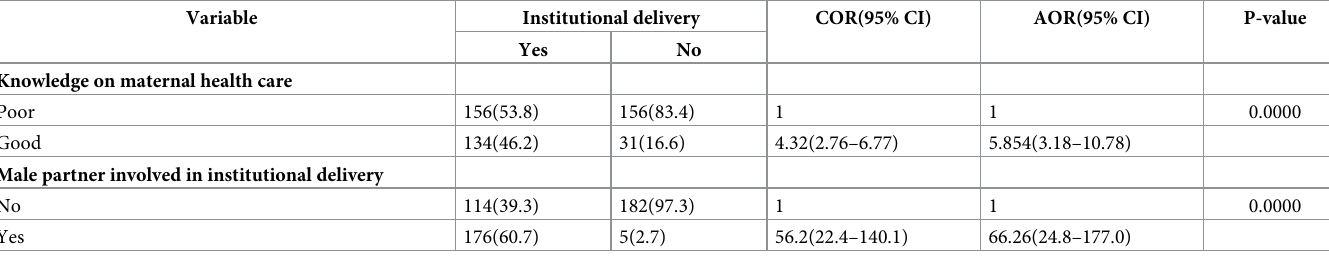
Table 5. The association between male involvement and women’s use of institutional delivery in Debre Tabor town, 2019 (n = 477).